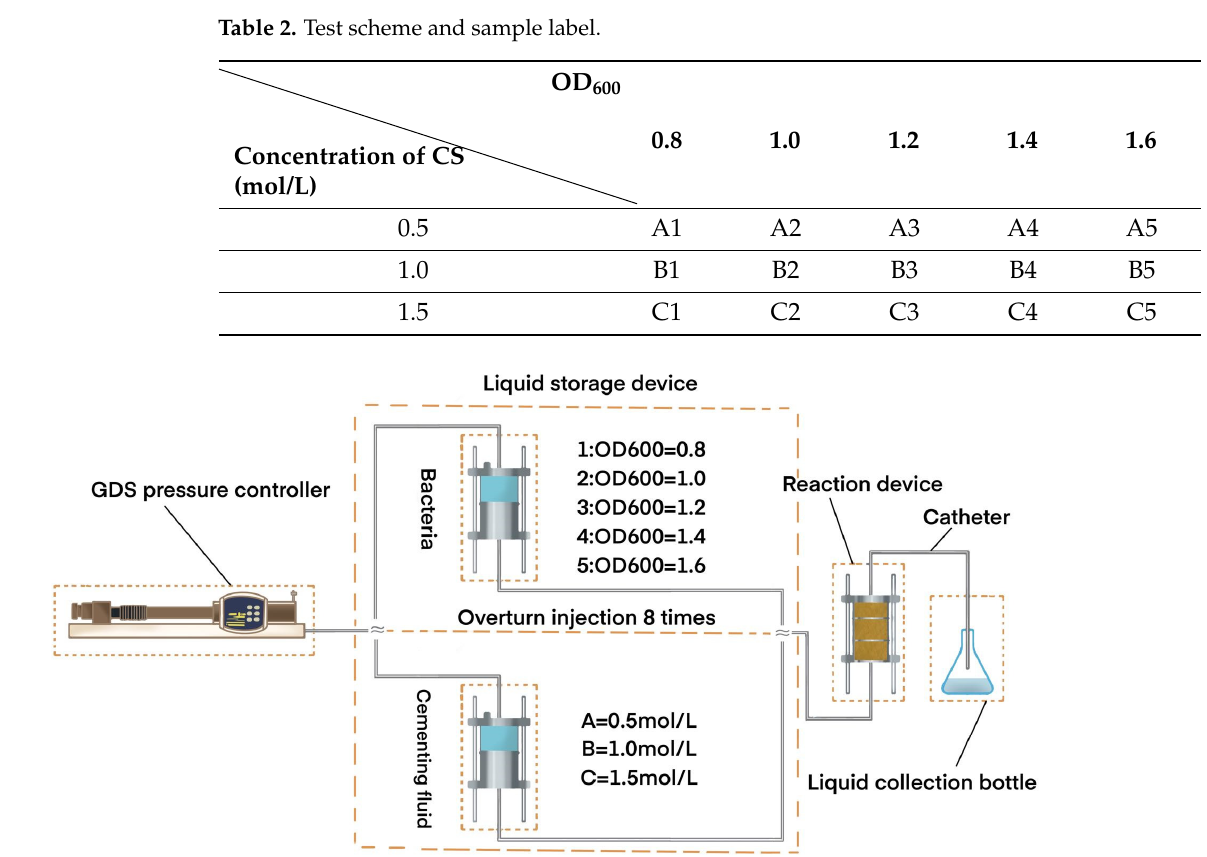
Figure 1. Schematic drawing of the testing procedure. Table 2. Test scheme and sample label.